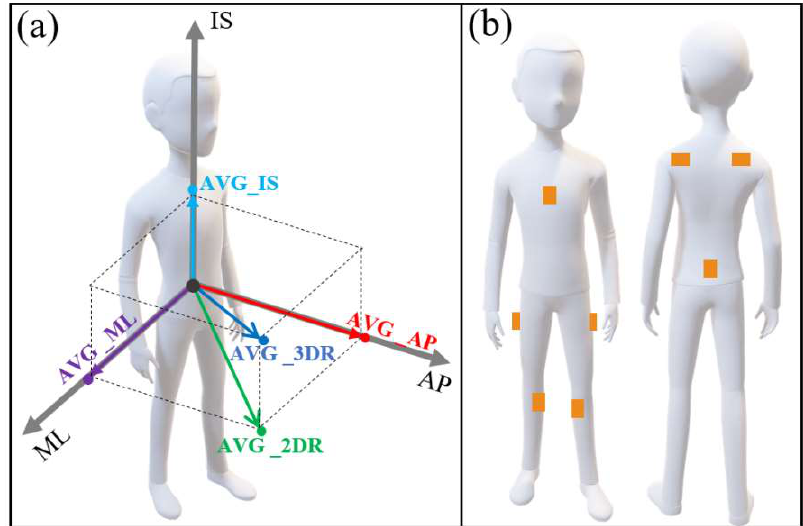
Figure 1. ( a ) Diagram of the ACC-based measures in different directions (such as ACC-based Aver- age (AVG), for example); ( b ) Configuration of the eight IMU sensors used in this